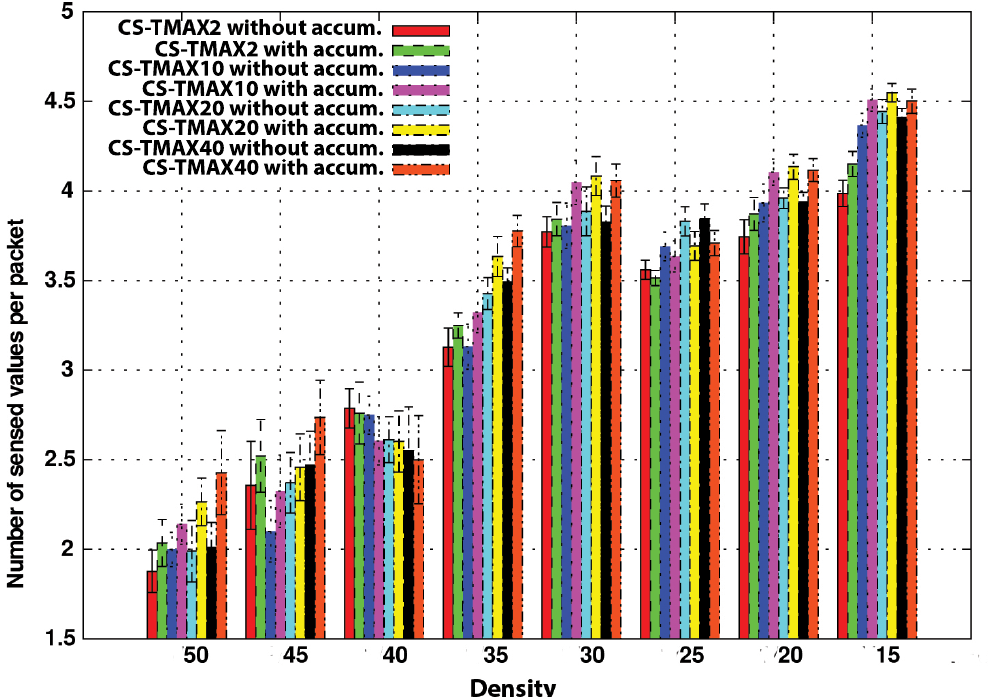
Figure 15. TMAX impact onto the carried data by